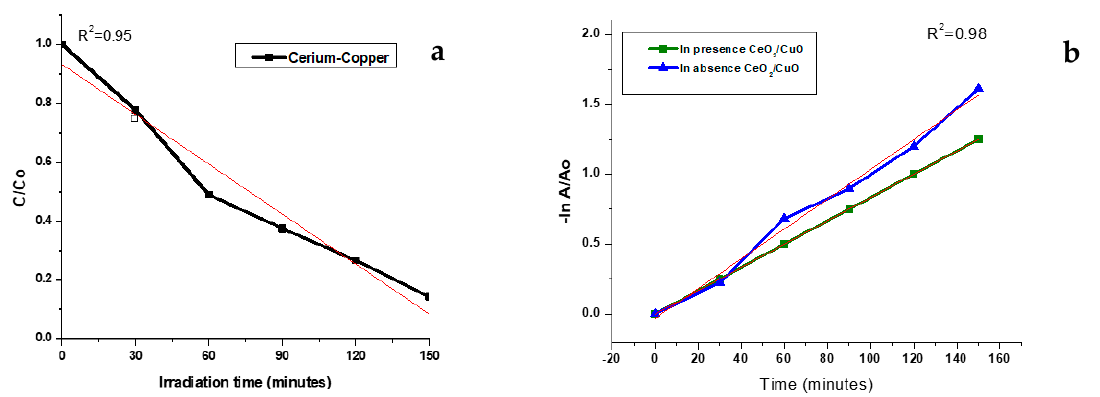
Table 2. Summary of some reported bimetallic oxides for photocatalytic dye degradation.